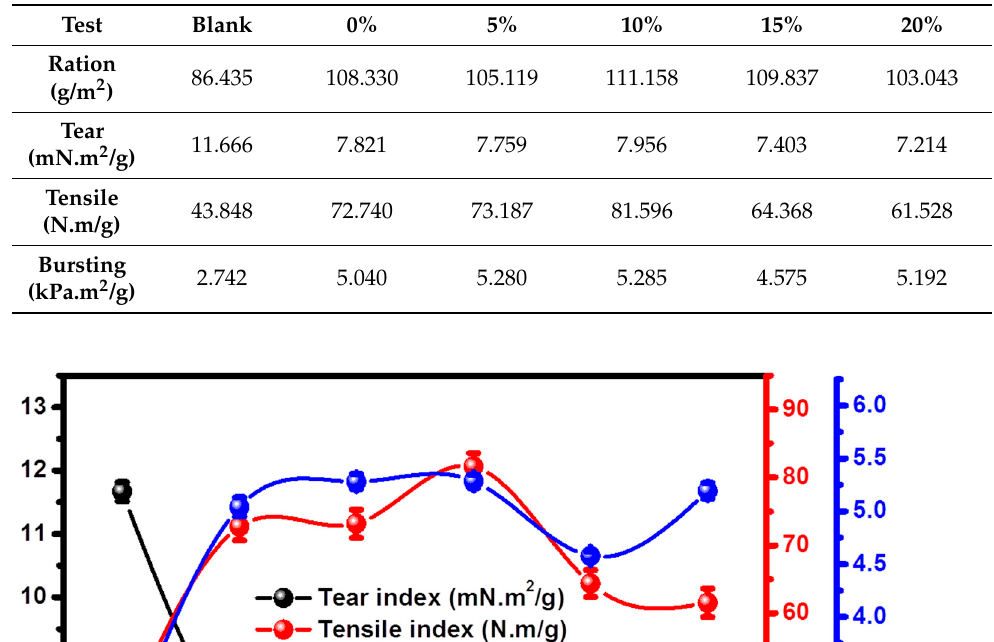
Table 1. The values of ration, tearing, tensile, and bursting tests of the blank paper and paper coated with PVAc and its copolymers containing different fractions of lignin.